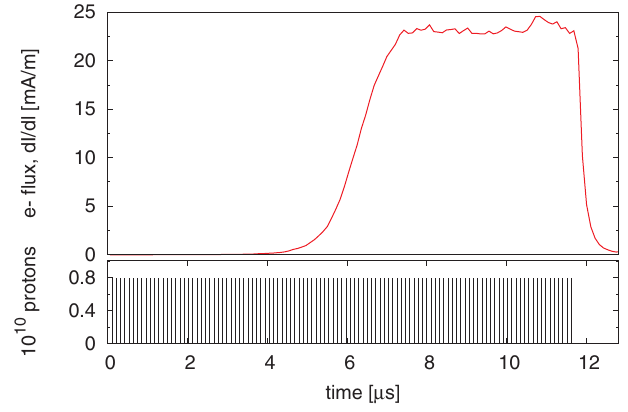
FIG. 1. (Color) The top plot shows a typical evolution of the electron flux during a revolution when RHIC is filled with a train of 110 bunches (bottom plot). This is a simulation using CSEC with an intensity of 8 (cid:7) 10 10 protons = bunch . The pressure is proportional to the time averaged electron flux in one turn, not